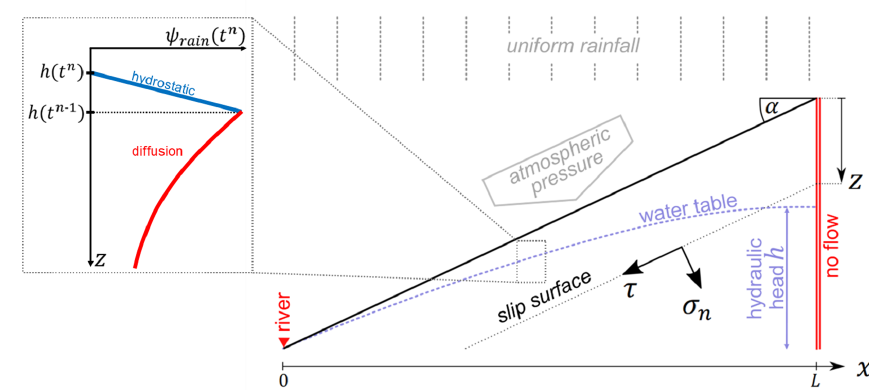
Figure 1. Geometry of the hillslope considered in this study. The water table (in blue) forms a quadratic surface between the two boundaries conditions (in red). The stability is evaluated with a Mohr–Coulomb criterion along a slope-parallel slip. The atmospheric pressure and rainfall infiltration are applied uniformly along the slope. The zoomed-in section shows the implementation of the diffusion of pore pressure due to the rise of the water table between two consecutive time